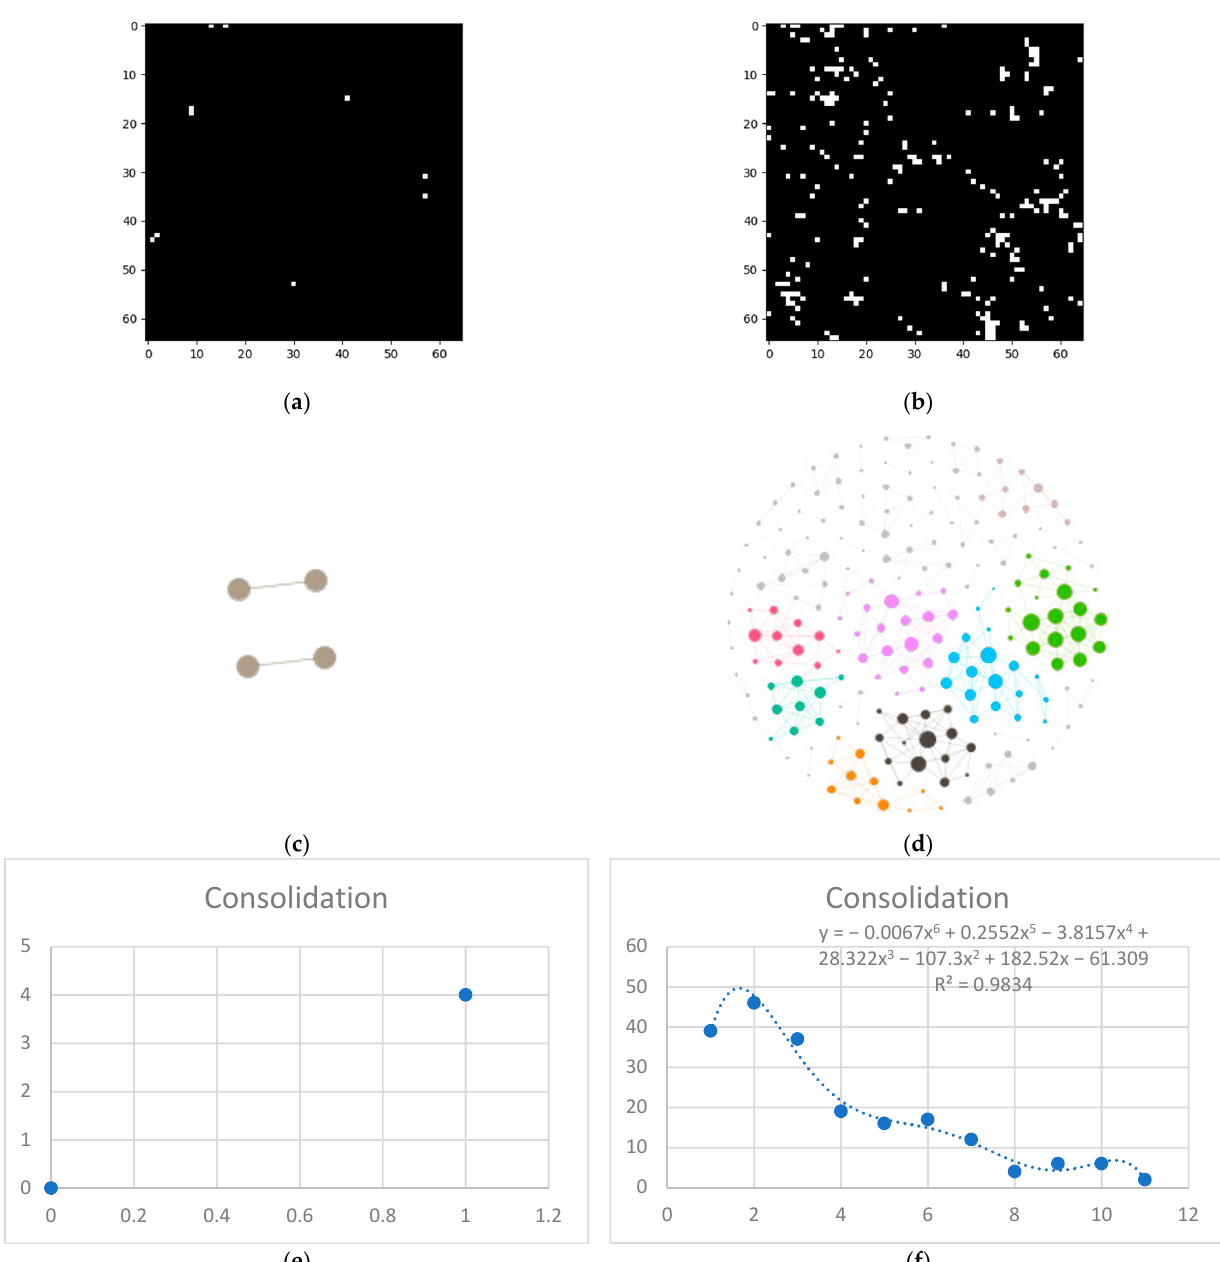
Figure 7. Consolidation processing ( a ) HU filtered layer for the normal sample; ( b ) HU filtered layer for the DILD sample ( c ) Complex network built according to the proposed algorithm corresponding to the normal sample, Fruchterman–Reingold render layout, node sizes proportional to node degrees, edge width invariant (1.5 pixels). ( d ) Complex network built according to the proposed algorithm corresponding to the DILD sample, Fruchterman–Reingold render layout, node sizes proportional to node degrees, edge width invariant (1.5 pixels). ( e ) Degree distribution of the normal sample network ( f ) Degree distribution of the DILD sample network. Equations for curve fit and R 2 are also presented for the relevant